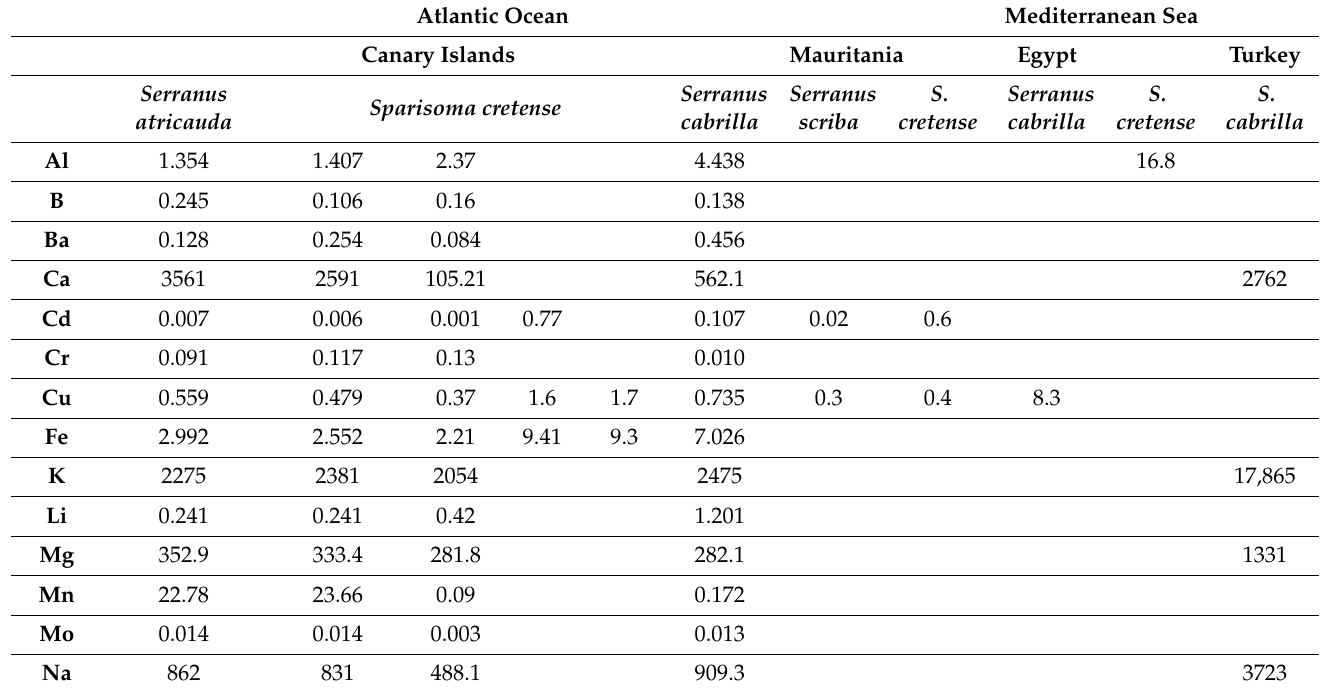
Table 10. Comparison with other authors